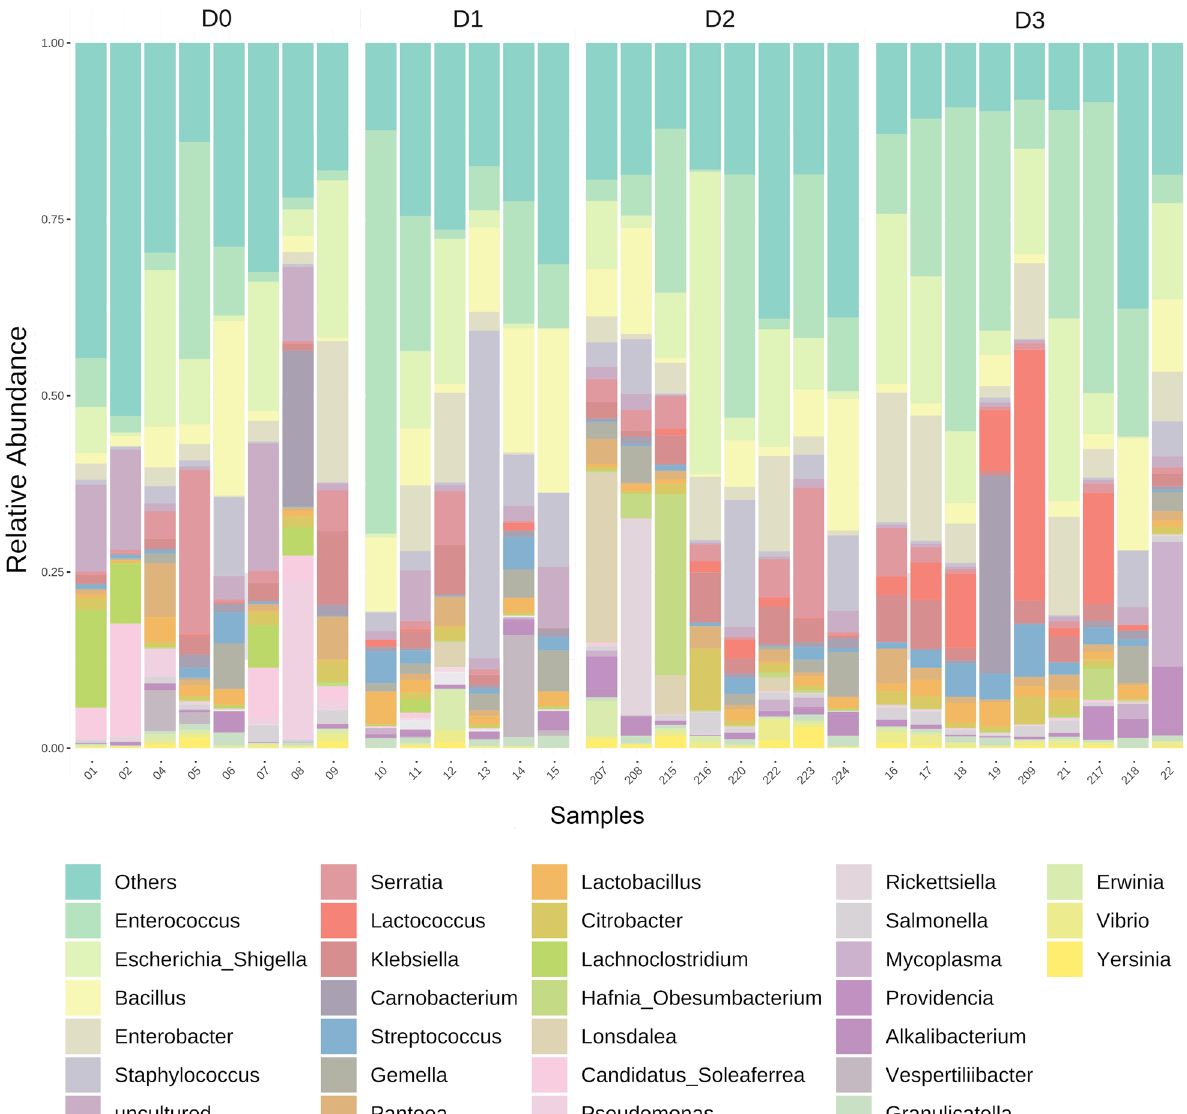
Fig. 2 Stacked bar plot of relative abundances of the top 30 most abundant genera from scenarios D0, D1, D2 and D3. Fecal samples are displayed on the bottom and scenarios displayed at the